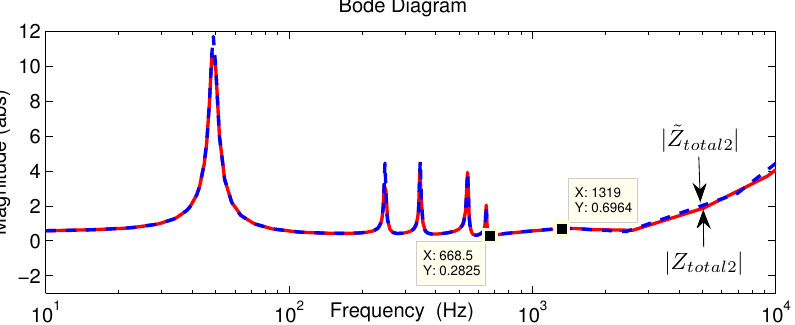
Figure 12. Magnitude of the impedances of bus 2 and its model with C Ld = 1 nF, R fd = 0.5 m Ω , and L fd = 1